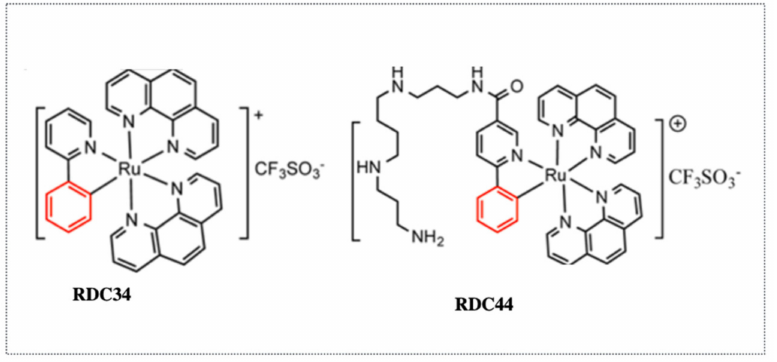
Figure 6. Ruthenium organometallic complexes RDC34 and RDC44 with fluorescent properties used for intracellular localization and cell